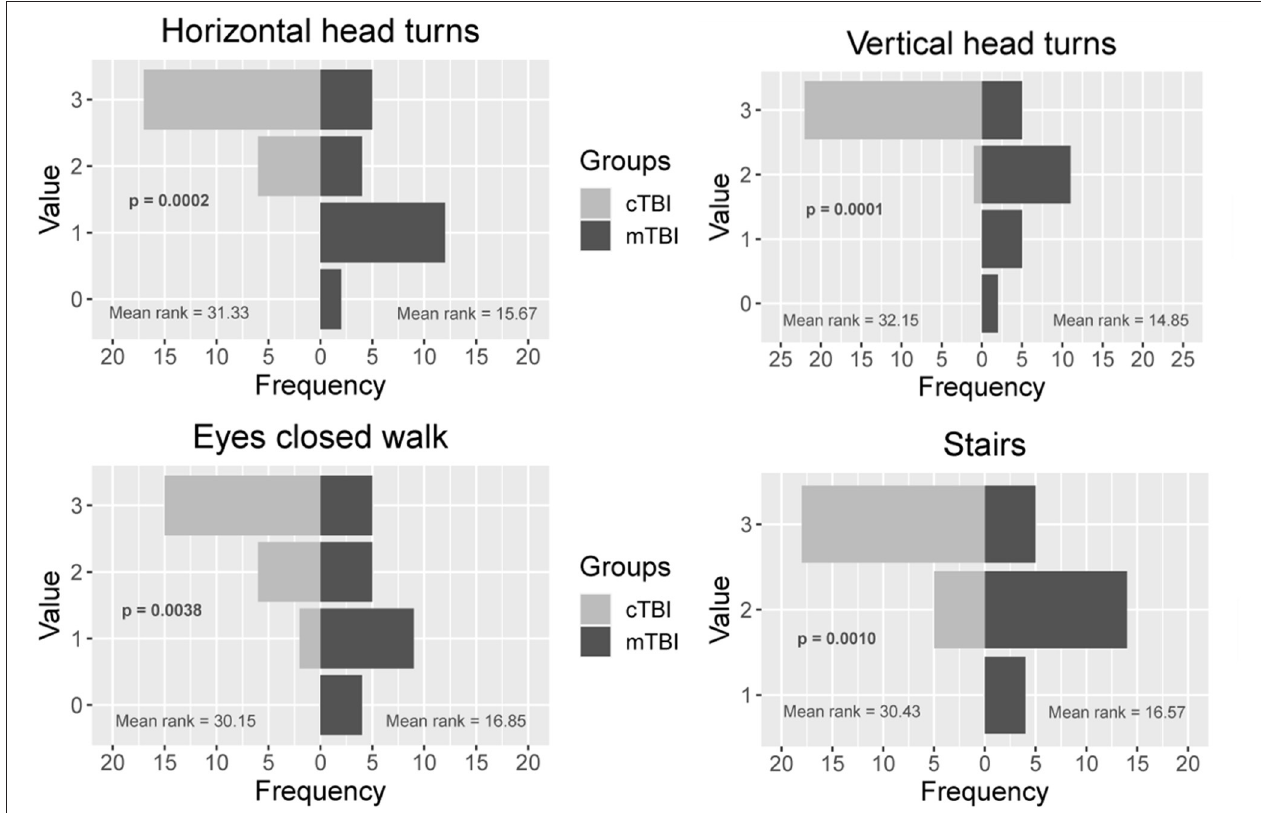
FIGURE 2 | Comparison between the control and mTBI group on 4 individual items of the Functional Gait Assessment. Values range from 0 to 3 where 3 = normal performance, 1 = mild impairment, 2 = moderate impairment, and 0 = severe impairment. mTBI, mild traumatic brain